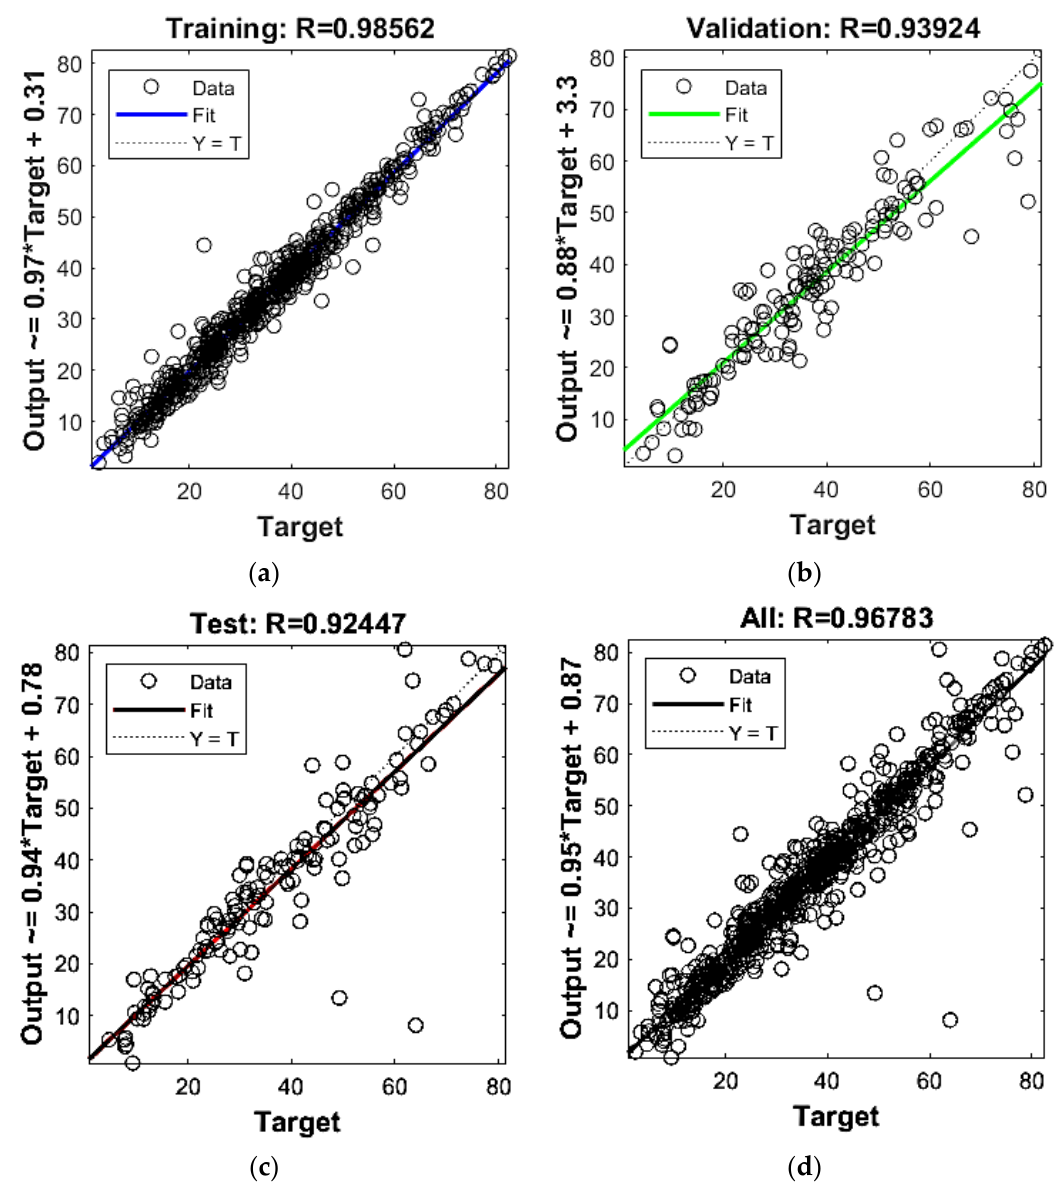
Figure 13. Regression for data training ( a ) Training regression; ( b ) Validation regression; ( c ) Test data regression; ( d ) Combined regression of training, validation and test data.